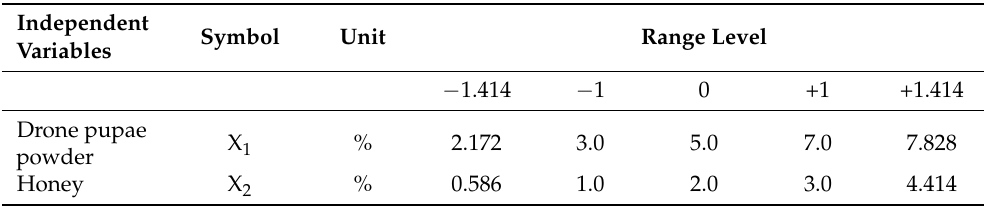
Table 1. Factors and coded levels for the central composite design of processing the puffed-rice snack. Independent